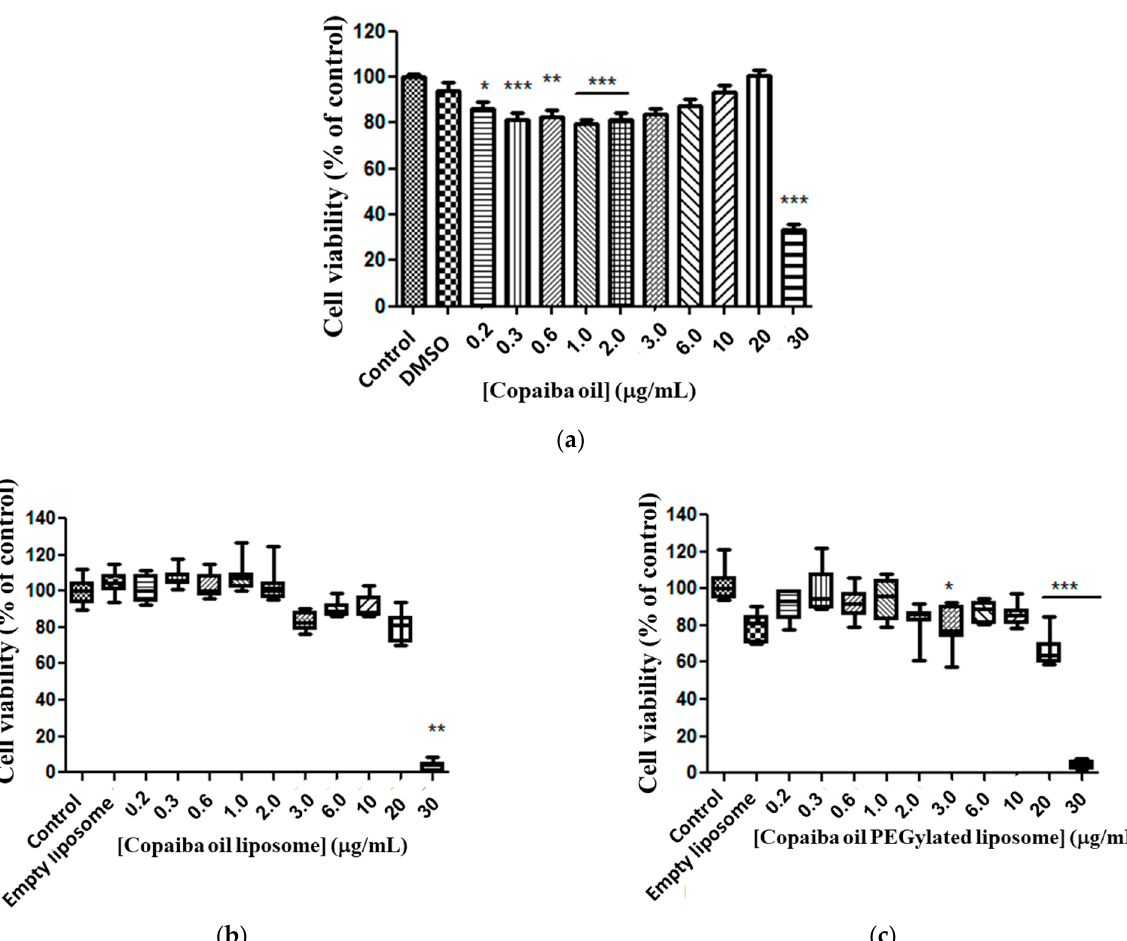
Figure 4. Copaiba oil cytotoxicity in glioma line cell (C6). Free CP ( a ); copaiba oil in conventional liposome (PC + CP) ( b ); CP in PEGylated liposomes (Phospholipon and lipopeg) ( c ) after exposure for 72 h, at doses 0.2–30 μ g/mL. Statistical significance shown as (*) p < 0.01, (**) p < 0.001 and (***) p < 0.0001 compared with the control (one-way ANOVA followed by Dunnett’s multiple comparison